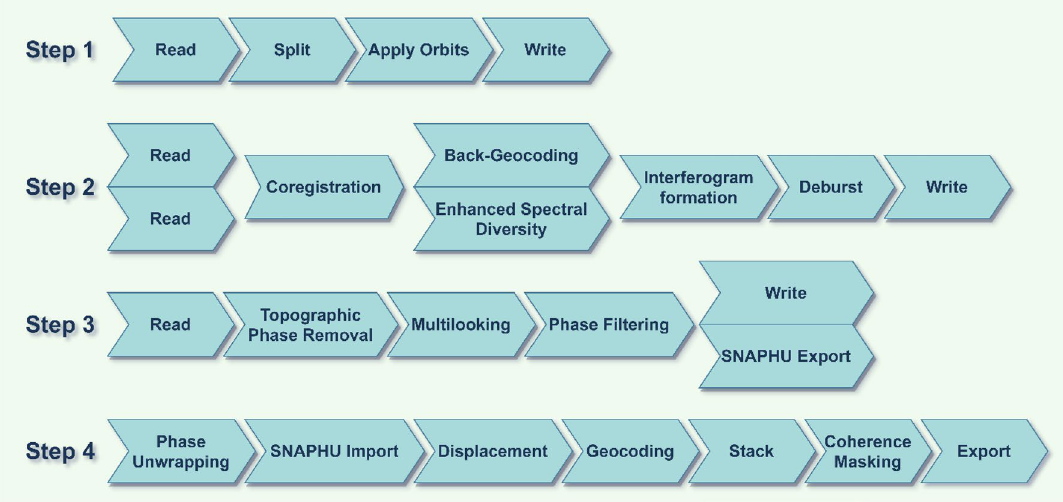
Figure 5. Schematic depicting the various chains of data processing of Sentinel-1 (InSAR) (Developed by the first author using draw.io (v. 14.9.6), https:// www. diagr ams. extracted from ALOS PALSAR DEM (12.5 m) using ArcGIS (v. 10.3) software (https:// search. asf. alaska. edu/). Factors related to drainage density and well density were prepared using the line density tool in ArcGIS (v. 10.3).